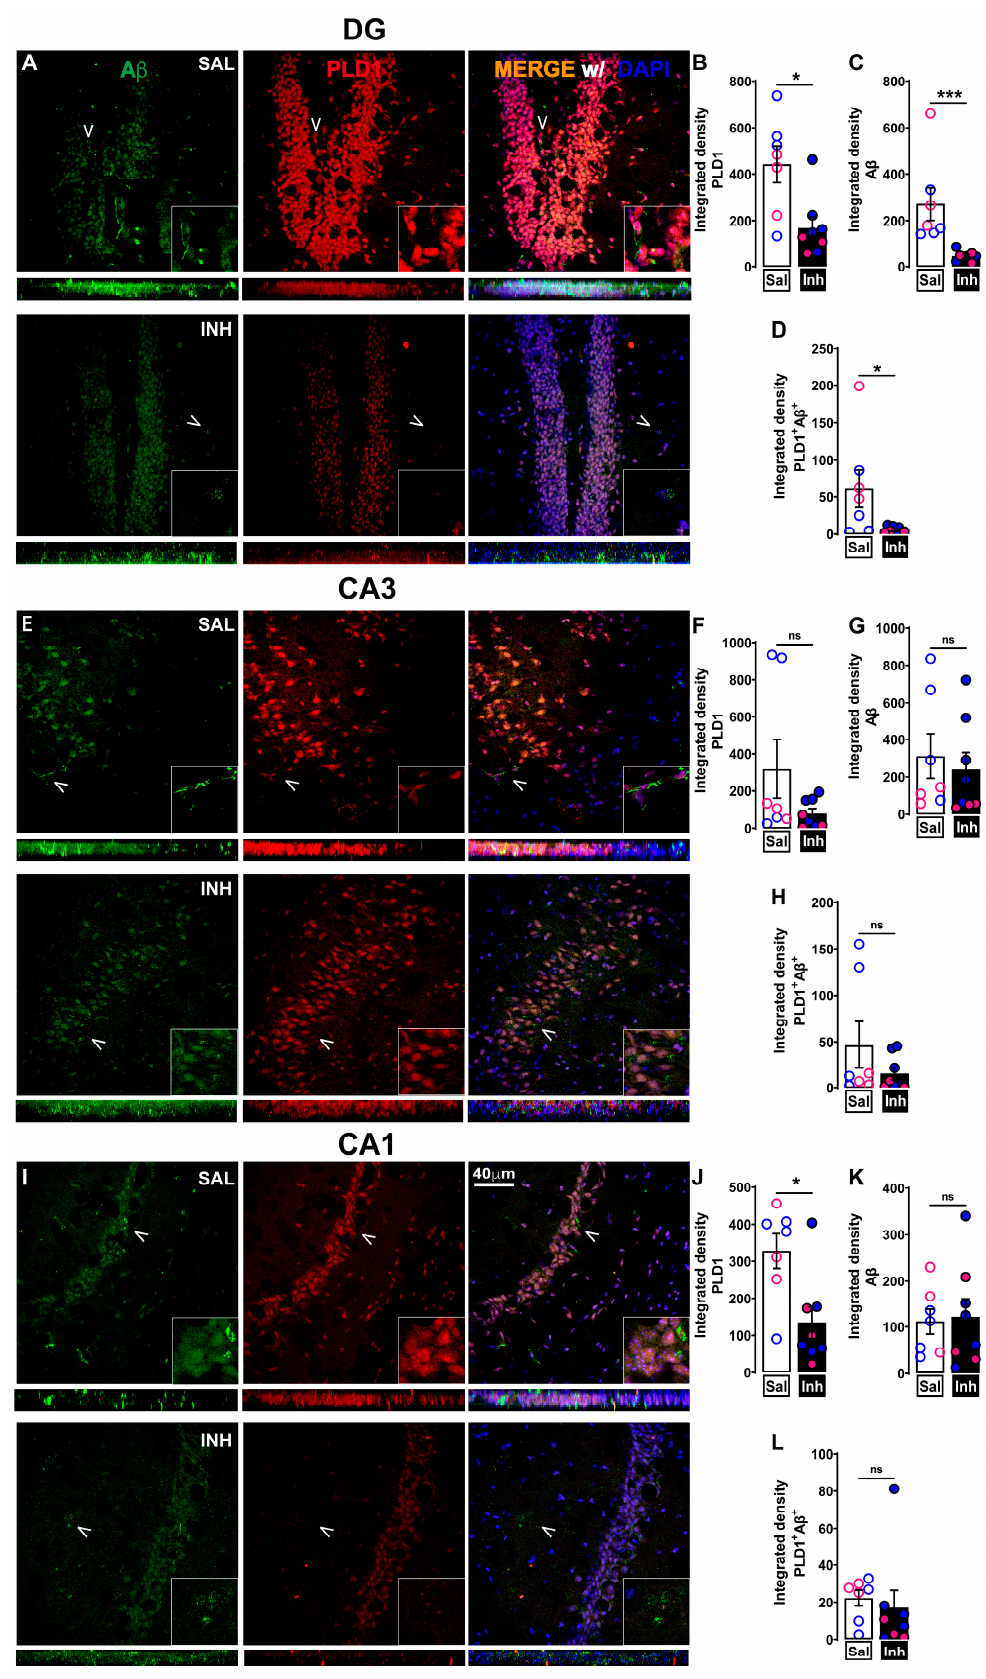
Figure 2. VU01 treatment (1 mg/kg/2 days for a month) in 12-month-old 3xTg-AD mice attenuates PLD1-A β expression differentially in hippocampal subregions. ( A ) Double immunofluorescence